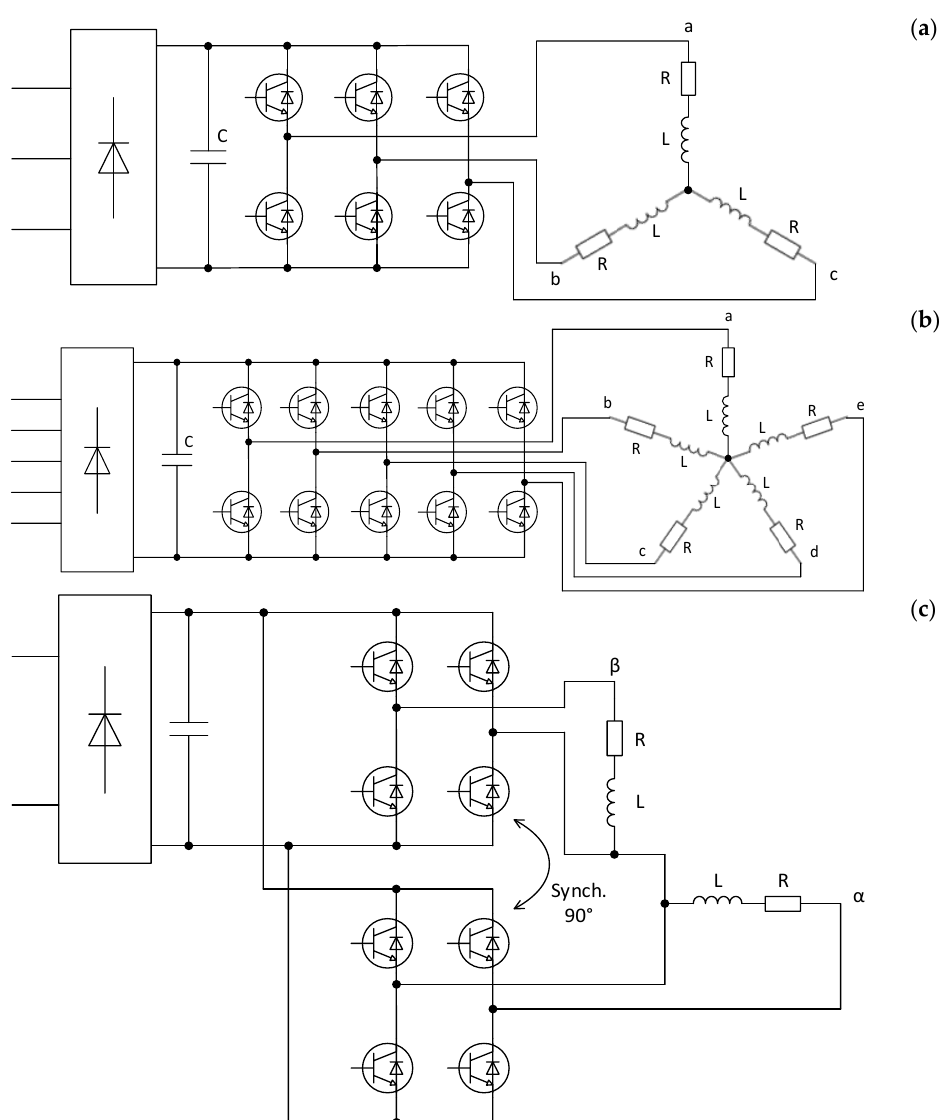
Figure 21. The basic scheme of the considered systems: 3-phase ( a ), 5-phase ( b ), and 2-phase ( c